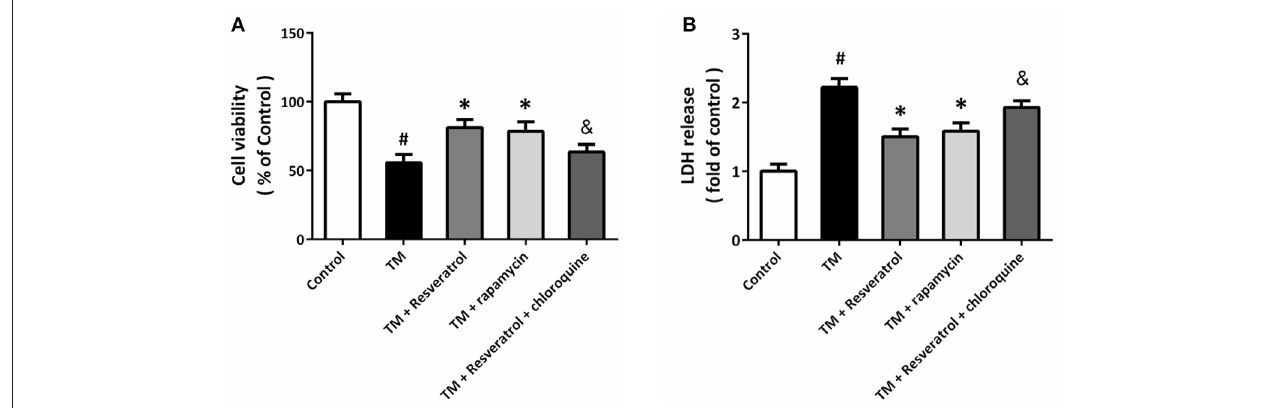
FIGURE 4 | Resveratrol modulates TM-induced toxicity via affecting autophagy. HT22 cells were treated with resveratrol, rapamycin or chloroquine, and exposed to TM for 24h. Cell viability was measured by MTT assay (A) , and cytotoxicity was determined by LDH assay (B) . Data are shown as mean ± SEM. # p < 0.05 vs. Control. * p < 0.05 vs. TM. & p < 0.05 vs. TM +